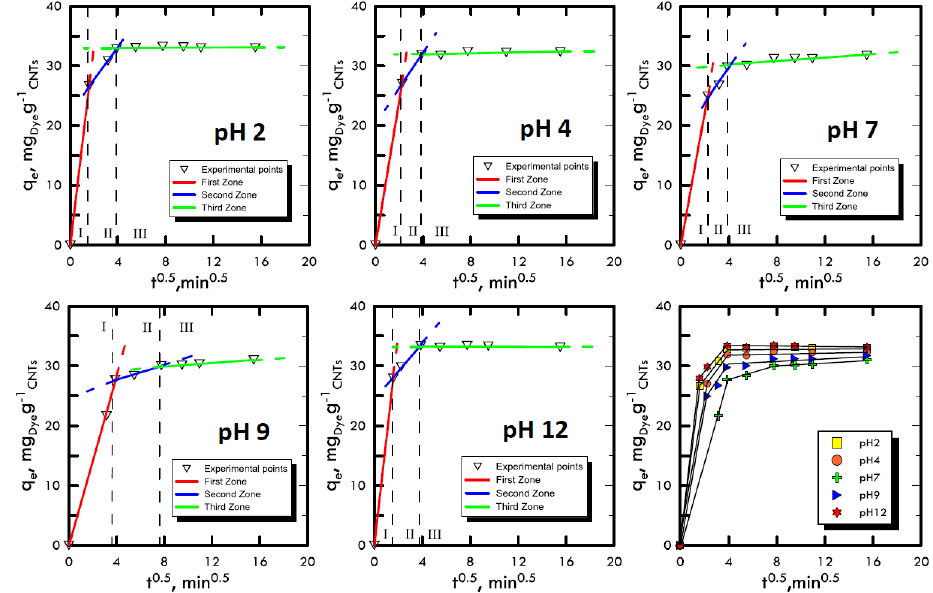
Figure 3. Weber and Morris method for the analysis of the transport mechanism RY-81 at di ff erent pH